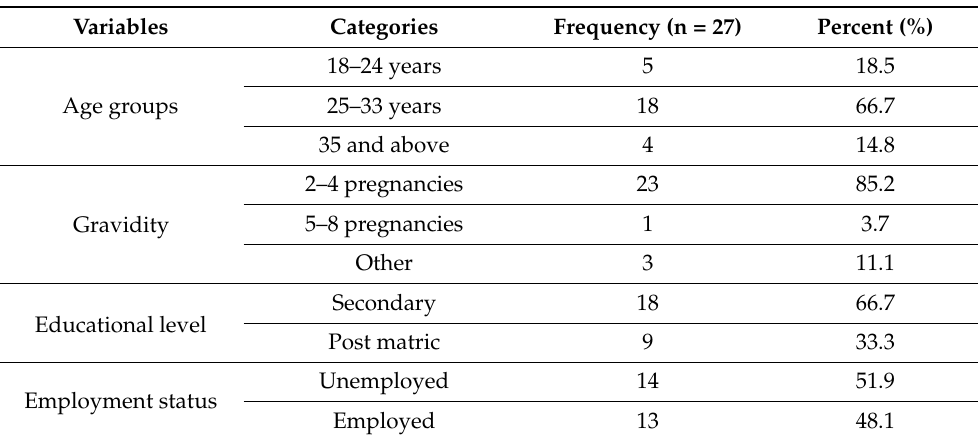
Table 2. Demographic characteristics of the participants.